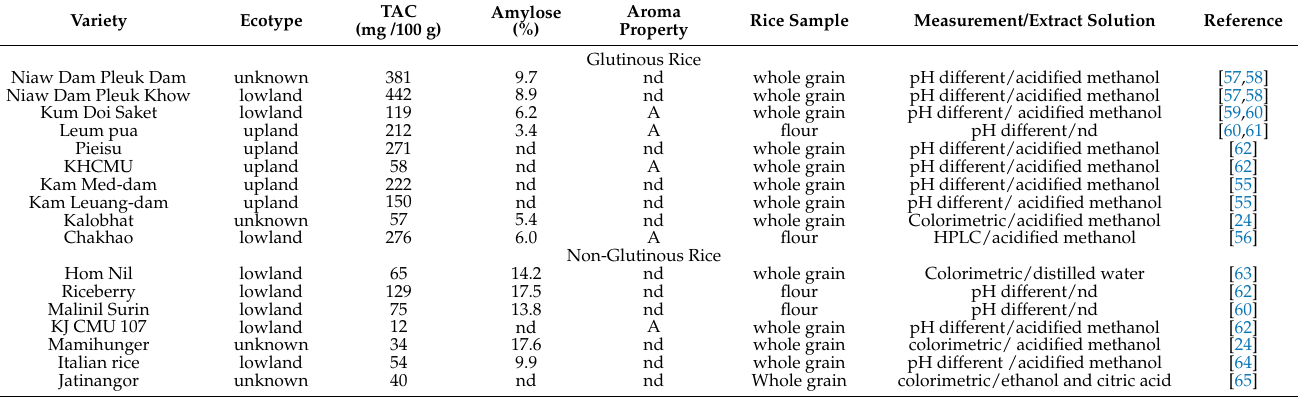
Table 2. Total anthocyanin concentration (TAC) and some chemical properties of purple rice varieties across two endosperm rice types. The ecotype, nature of rice sample, and measurement method are also listed.